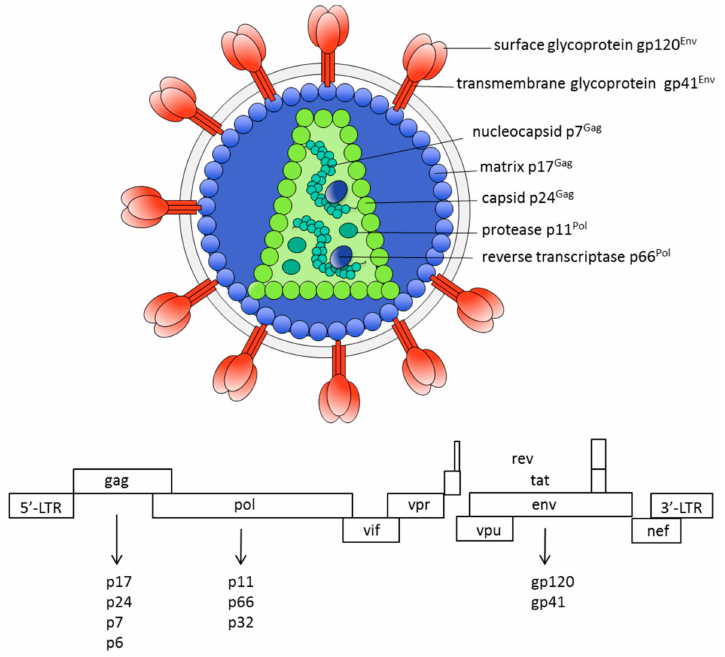
Figure 1. Human immunodeficiency virus type 1 (HIV-1) genome and